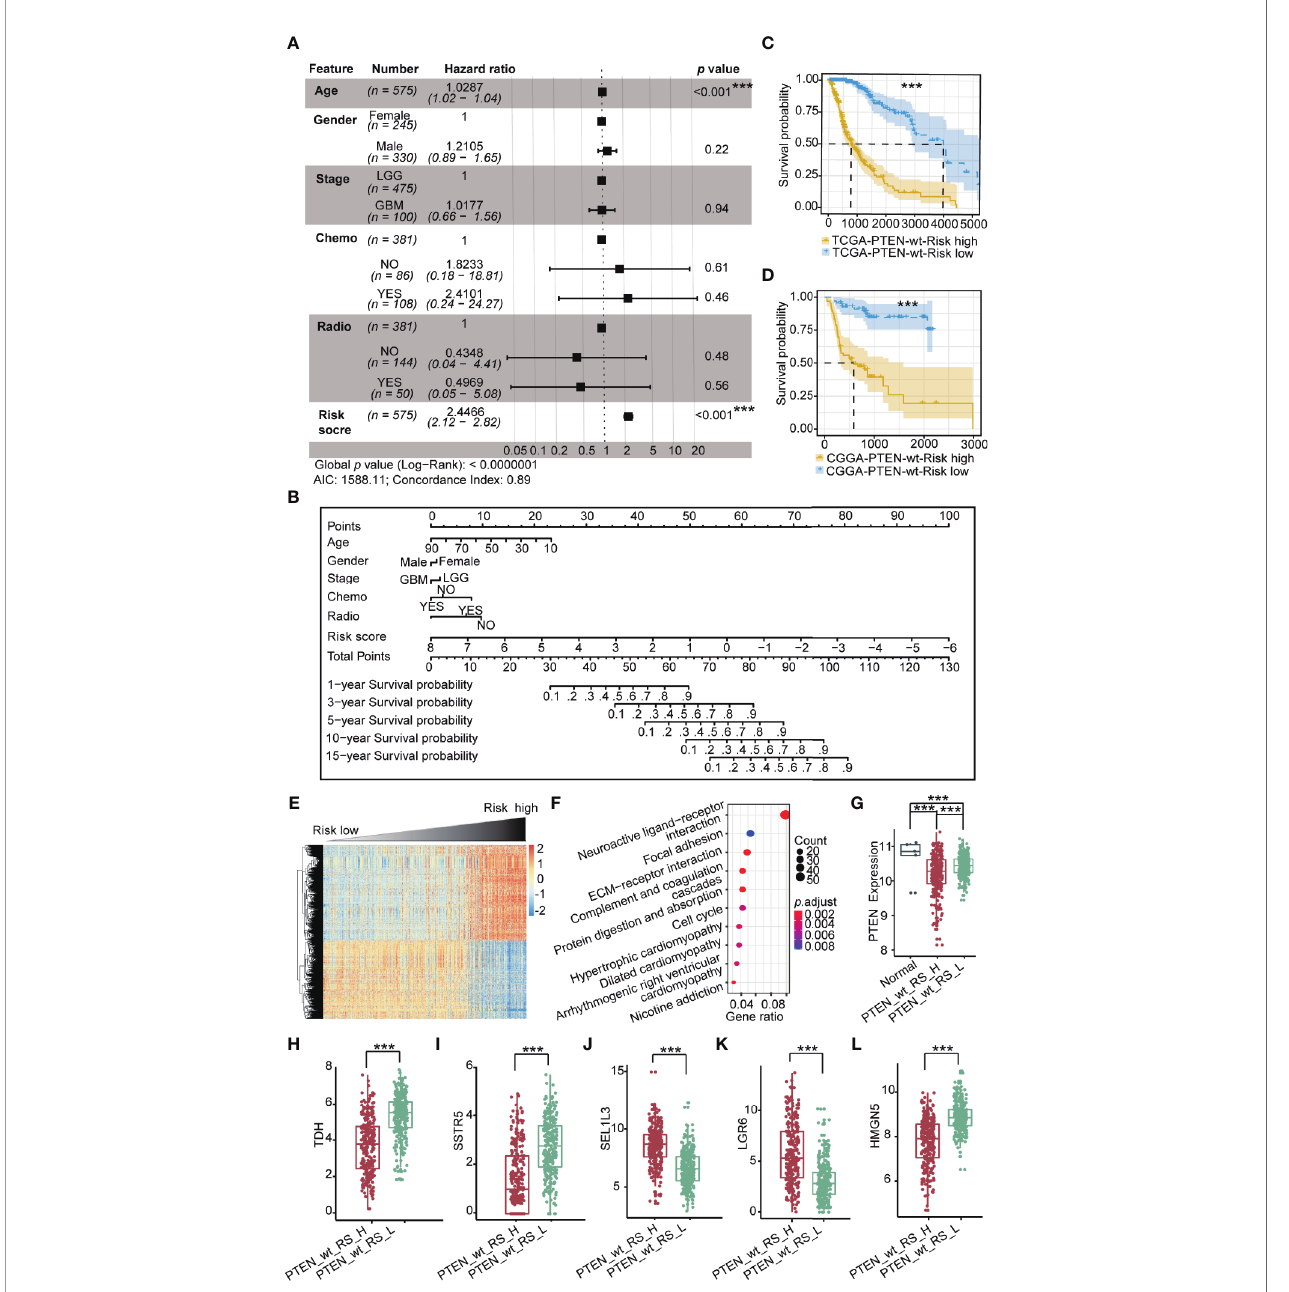
FIGURE 3 | Prognostic risk model in TCGA PTEN-wt subgroup: (A) Multivariate Cox forest plot of risk score and clinical features in TCGA PTEN-wt subgroup ( n = 575 , AIC = 1588.11, C-index = 0.89); (B) A nomogram incorporating risk score based on 44 OPR-DEGs ( Supplementary Table 5 , risk score in Supplementary Table 1 ) and clinical features in TCGA PTEN-wt subgroup; (C) Survival analysis (Kaplan Meier Curve) of high-risk score patients (PTEN_wt_RS_H, blue, n = 287) and low-risk score patients (PTEN_wt_RS_L, yellow, n = 287) in TCGA PTEN-wt subgroup (high-risk score and low-risk score separated from the median risk score of